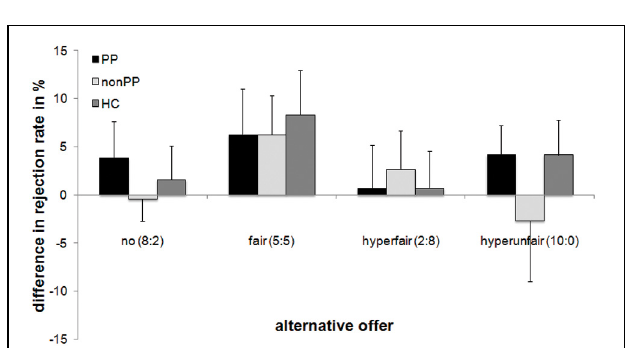
FIGURE 4 | Difference between intentional and unintentional unfair offers with regard to alternative offers and group. Mean percentage and standard errors of rejection of 8:2-offers are displayed. PP, offenders with psychopathy; non-PP, offenders without psychopathy; HC, healthy